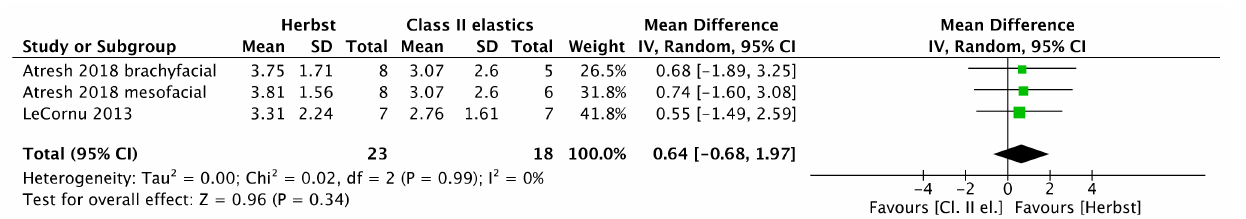
Figure 15. Forest plot of the left mandibular corpus length changes using the random effects model [43,44].